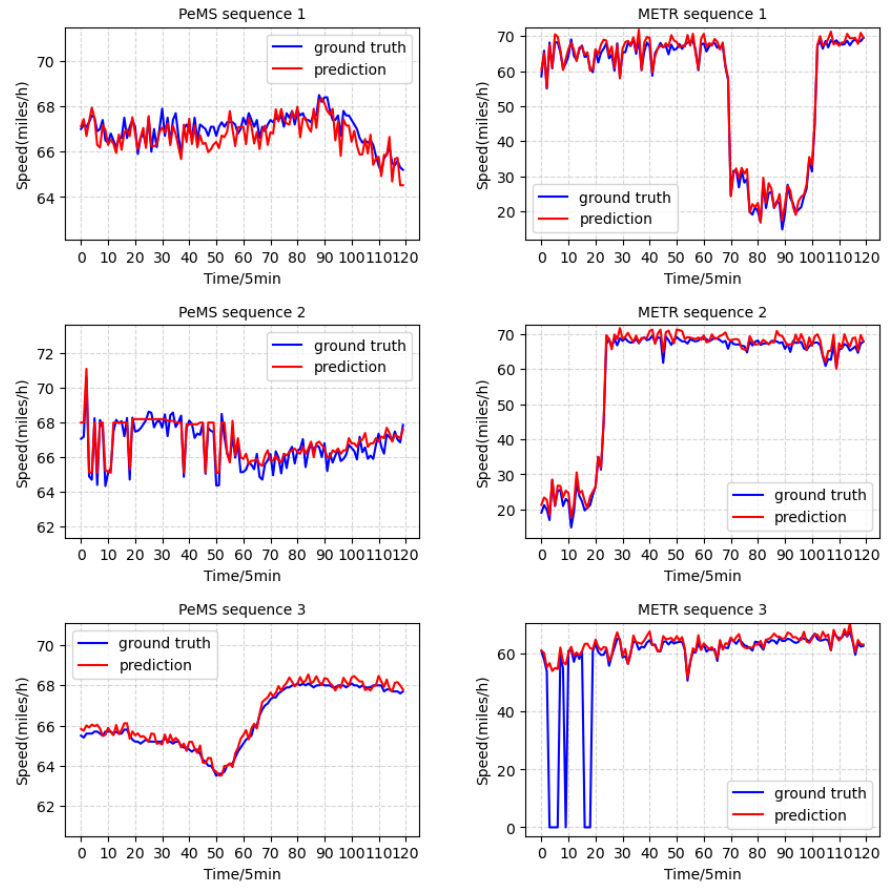
Figure 3. Visualization of the ground-truth speed sequence and the prediction results obtained on the PeMS and METR datasets.